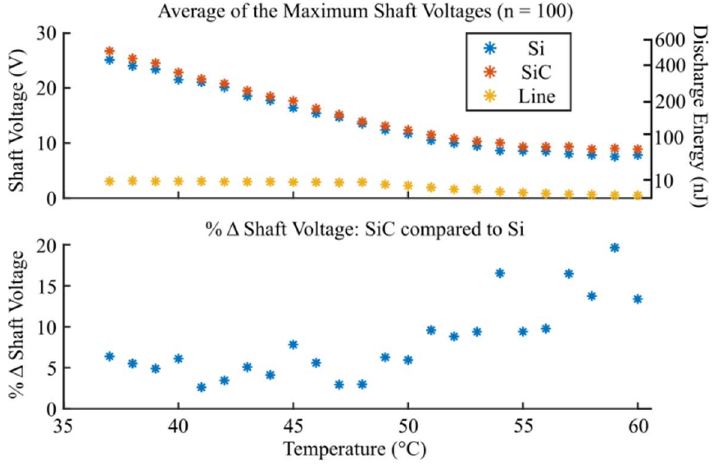
Figure 17. Comparison of maximum shaft discharge voltages at various bearing operational temperatures for Si and SiC inverters, with line-driven operation included.